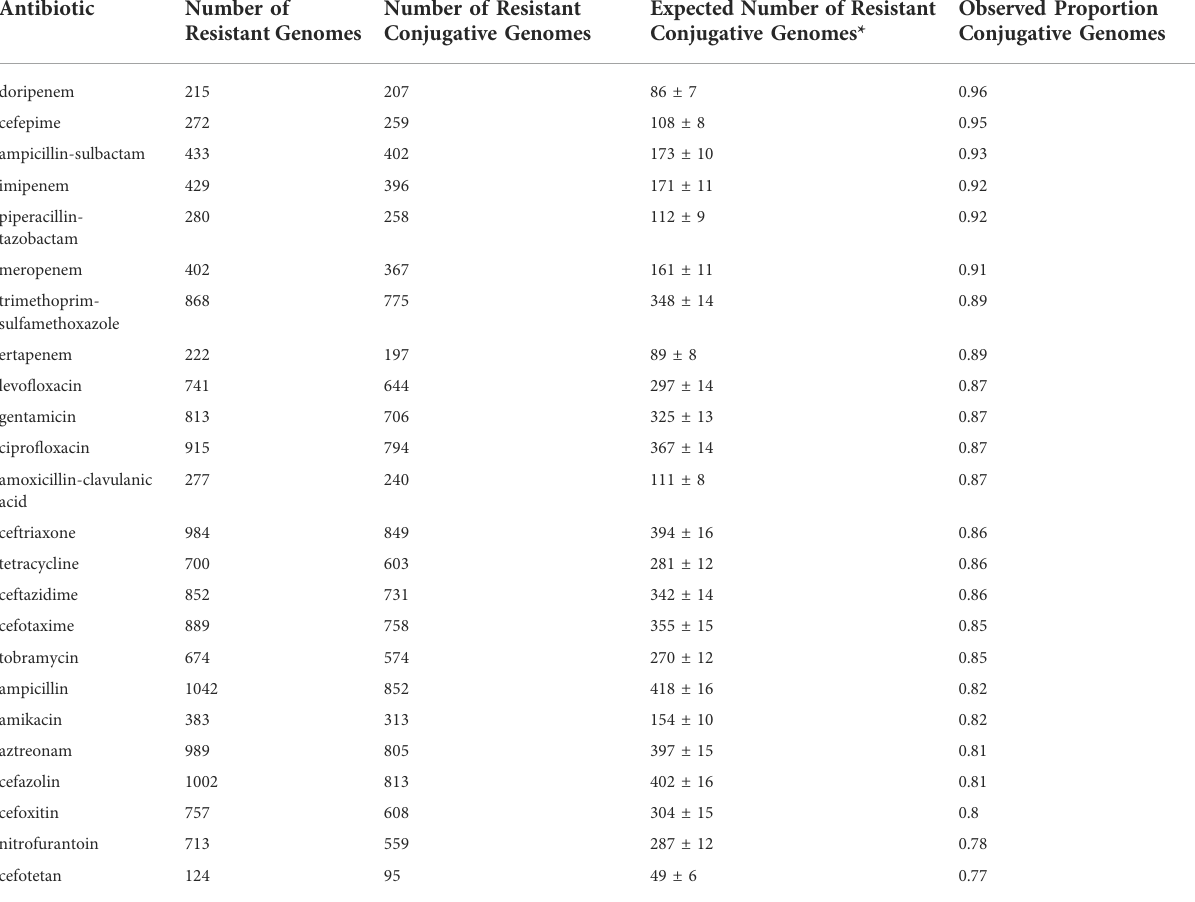
TABLE 5 Associations between phenotypic AMR and representation of conjugative versus non-conjugative genomes.